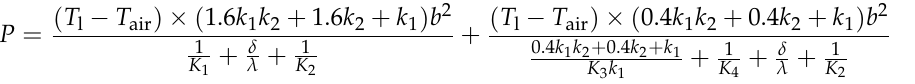
is 1.1:1:1, the minimum heat dissipation power is 1496.4 W. In addition, if the length proportional coefficient k 1 is constant, the power increases with the increase of the height ratio coefficient k 2 . The maximum power increases by 3.0% compared with the minimum power. If k 2 is constant, the power decreases first and then increases with the increase of k 1